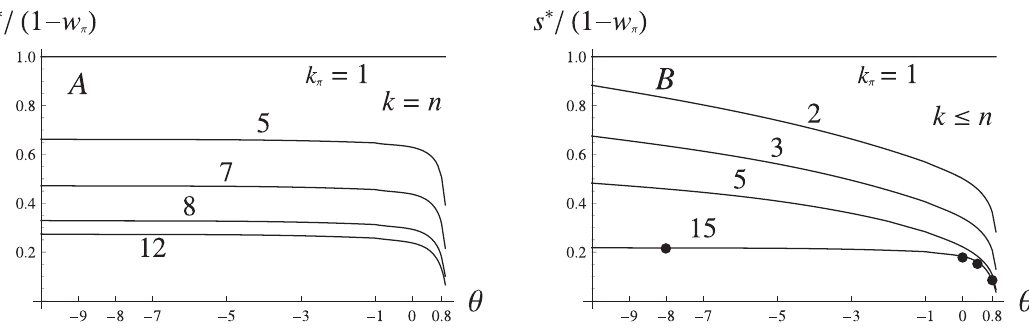
Figure 5. Effective selection ( s *) on the individual genes. A – s * as a proportion of the total selection on the initial block, with the number of genes in the initial block varying from 1 to 15, and epistasis h ranging from 2 9 to 0.8. The maximum number of genes is fixed at n =15. B – the same as in B, but the maximum number of genes, n , is set to equal k p in each case. Points along the curve for 15 loci correspond to the frequency distribution plots on A. Other parameters: S =0.7, r =0.01, m